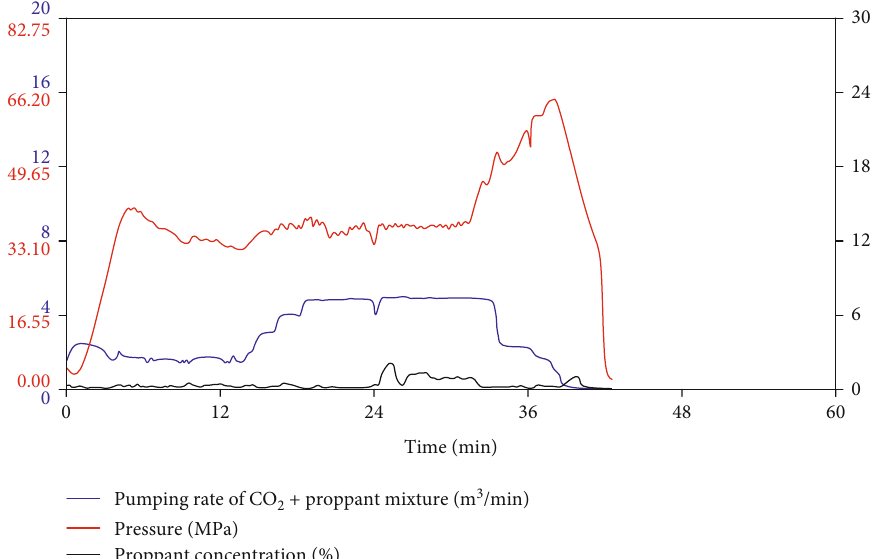
Figure 11: Curves of fracturing with old thickener Znj01 for Well Hong 87-X at pumping rates of 4.8 – 5.1m 3